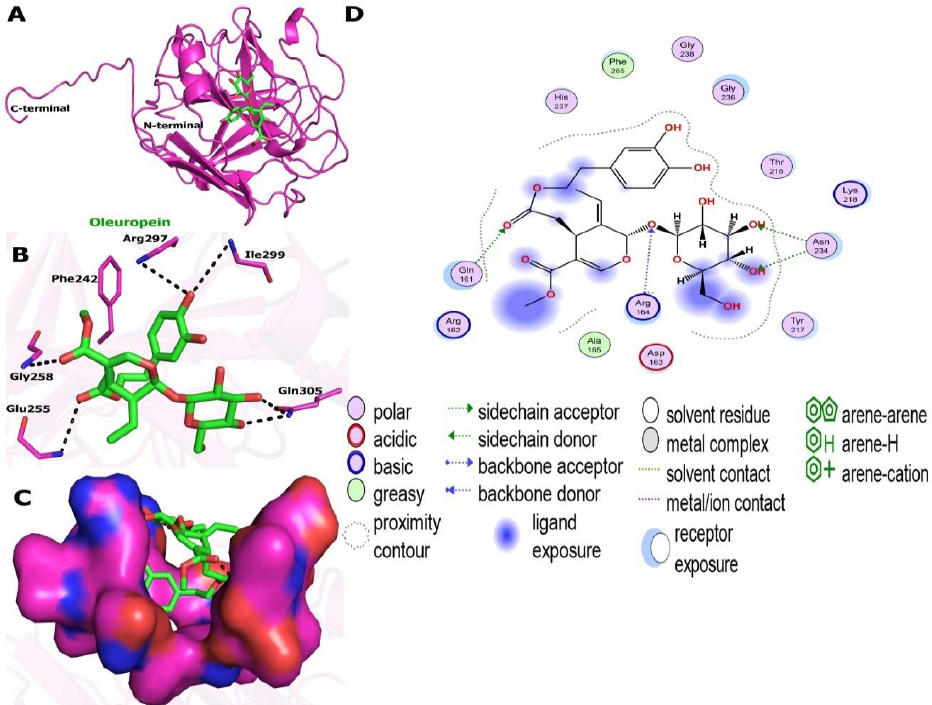
Figure 9. Molecular docking study of oleuropein toward the binding pocket of EFLec . ( A ) The surface representation of the active-site flap of EFLec with ligand, shown at the entrance of the binding pocket. ( B ) Amino acids involved in a hydrogen bond with oleuropein are shown as sticks. PyMol created these figures. Oleuropein (cyans), the crystal structure of EFLec (NCBI ID WP_033741131.1) (greens), and oxygen atoms are presented in red, and nitrogen atoms are shown in blue and purple dashed lines assigned to the bonding interactions. ( C ) Electrostatic surface of EFLec . Positive charges are in blue, negative charges are in red, and neutral charges are in purple. ( D ) Van der Waals and alkyl interactions with the residues of the catalytic site that are crucial for inactivating the